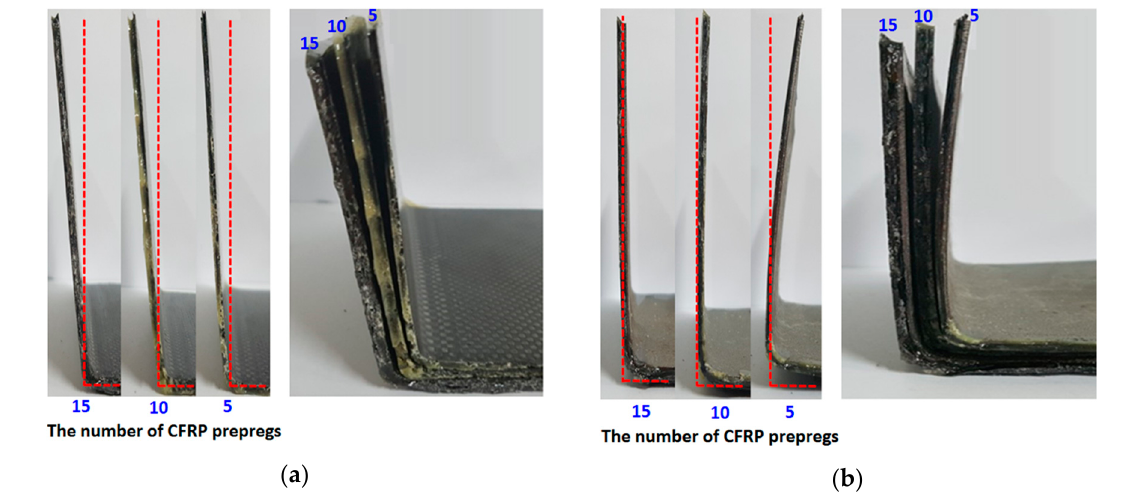
Figure 3. Formed hybrid composites through V-bending test: ( a ) CFRP / CR980; ( b ) CR980 / CFRP.